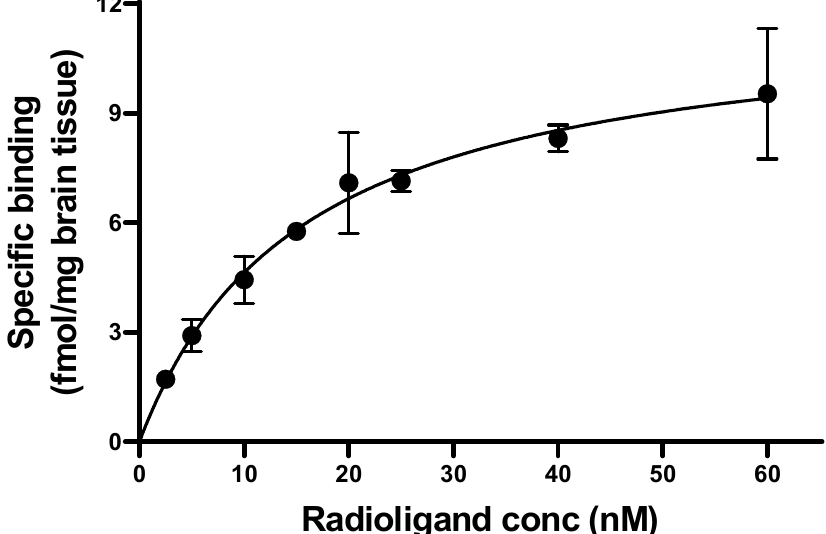
Figure 3. Binding assay of [ 11 C]MPC-6827 in mouse brain homogenates ( n = 6). HPLC metabolite analysis [33] of the plasma and brain samples indicated that the percentage of the parent unmetabolized [ 11 C]MPC-6827 was 98.5 ± 1.5% of total plasma radioactivity at 5 min; 97.7 ± 0.88% at 15 min; 97.1 ± 1.1% at 30 min; 95.7 ± 12.9% at 60 min; and 93.6 ± 2% at 90 min. With brain samples, the percentage of [ 11 C]MPC-6827 was 99 ± 0.8% at 5 min; 98.2 ± 1.5% at 15 min; 97.1 ± 2.2% at 30 min; 95.4 ± 1.5% at 60 min; and 94.3 ± 2.0% at 90 min. HPLC analysis showed a minor peak with a retention time of 3–4 min in both plasma and brain samples. The extraction efficiency and column efficiency for all metabolite analyses were ~92 ± 1% and test–retest characteristics were statistically significant ( r = 0.75). (Figure 4).